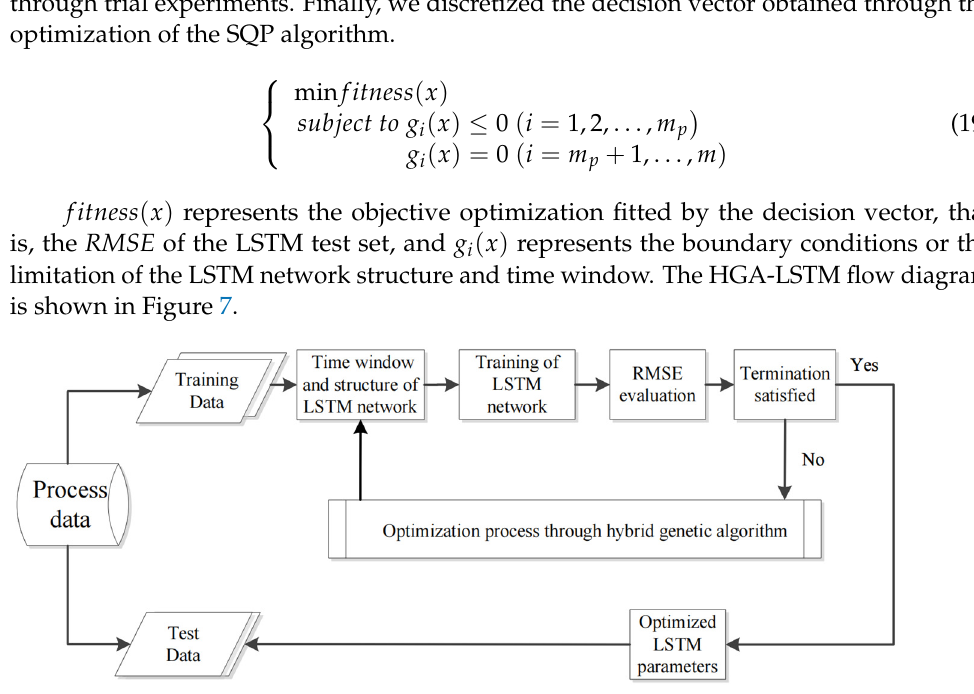
Figure 7. Flow diagram of the HGA-LSTM algorithm.